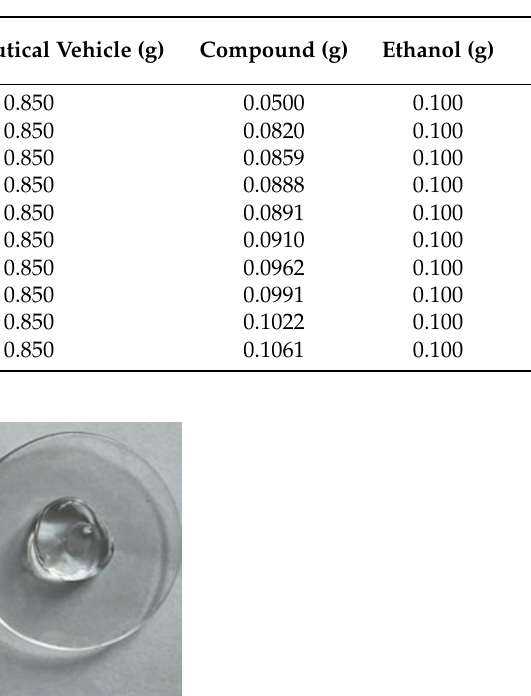
Table 1. Composition of obtained hydrogels.